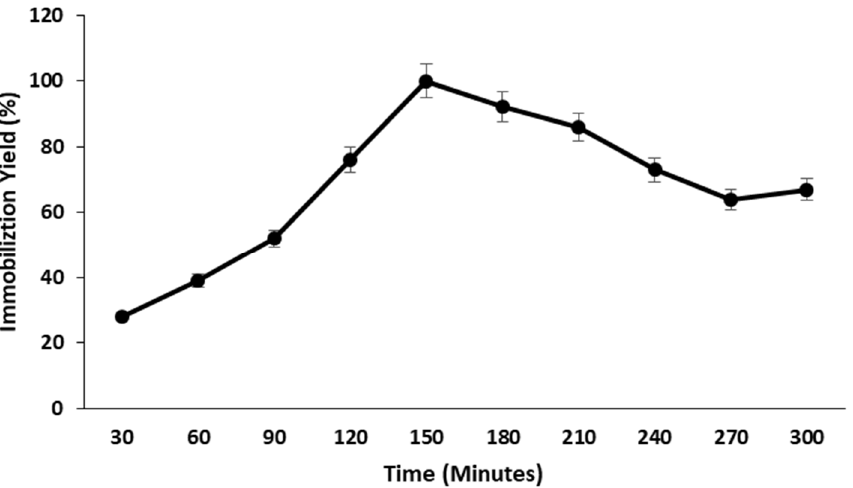
Figure 4. Effect of crosslinking time on the magnetic iron oxide nanocarrier.